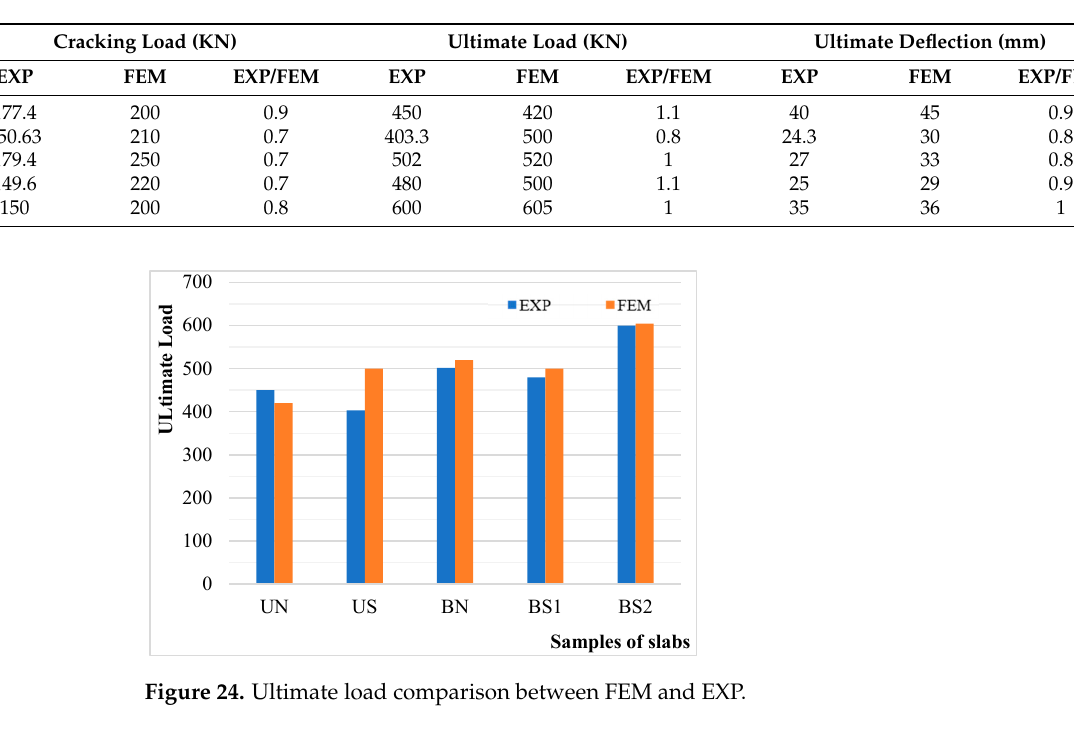
Figure 23. Load-deflection curve of US slab.